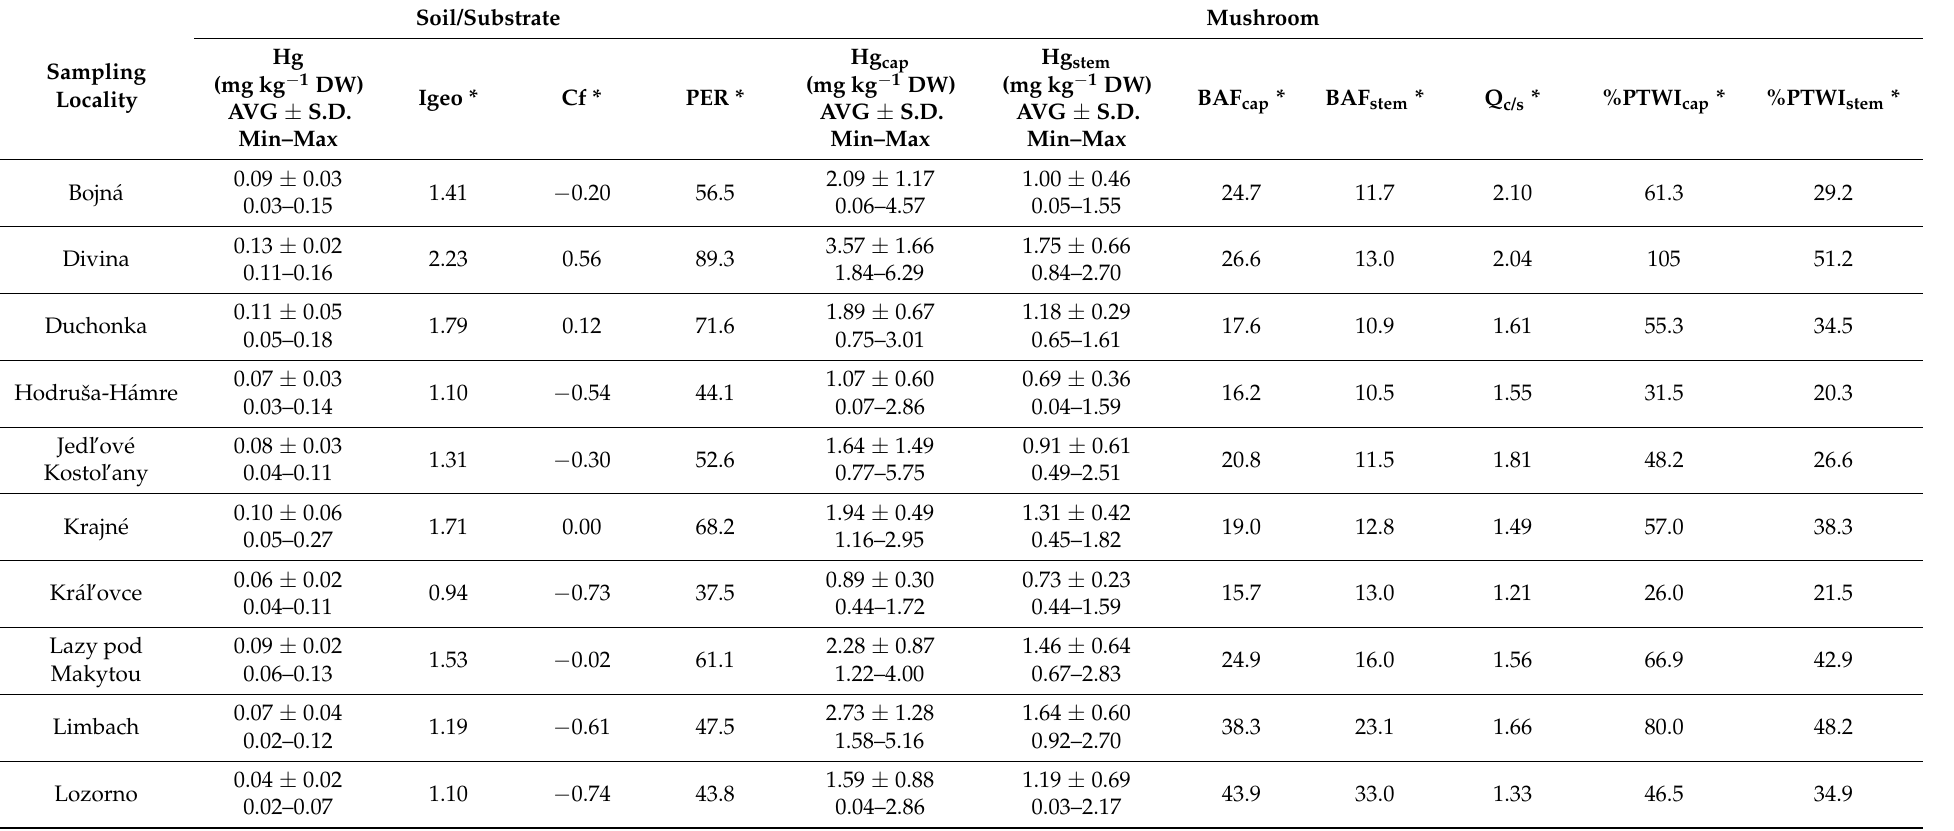
Table 2. Mercury content in soil/substrate and mushroom samples and ecological and health risk